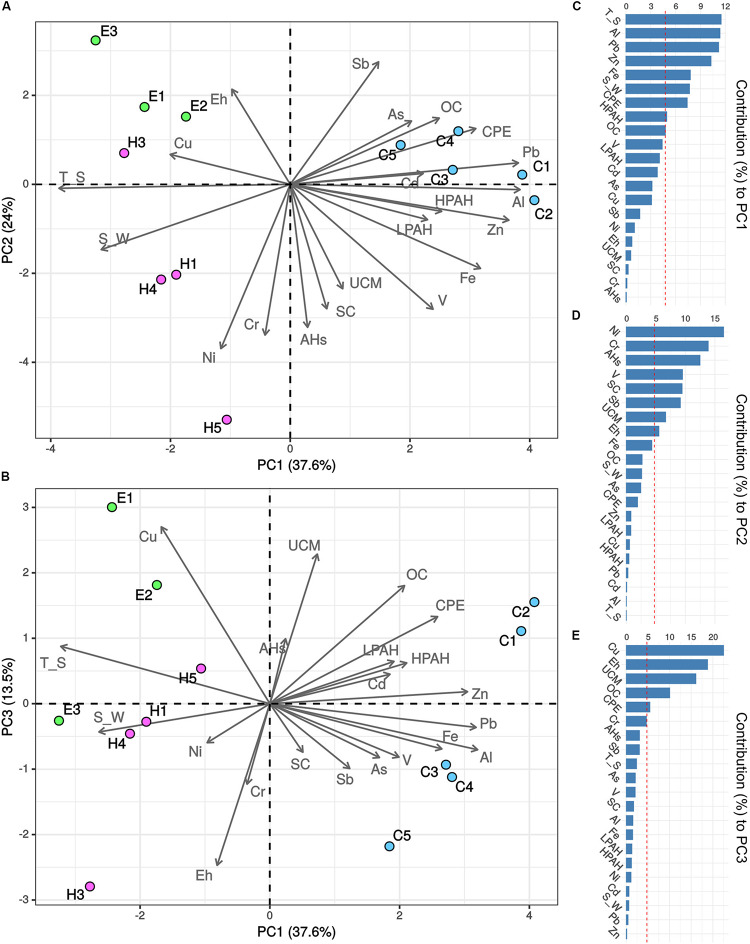
Principal component analysis (PCA) of environmental and pollution variables recorded in the ports of Cagliari (C, blue), El Kantaoui (E, green), and Heraklion (H, pink). Biplots showing (A) PC1 vs. PC2, (B) PC1 vs. PC3. The percentage of the variation explained by each axis is indicated in parentheses after the axis label. Variable contribution to the first (C), second (D), and third (E) component is reported as percentage.